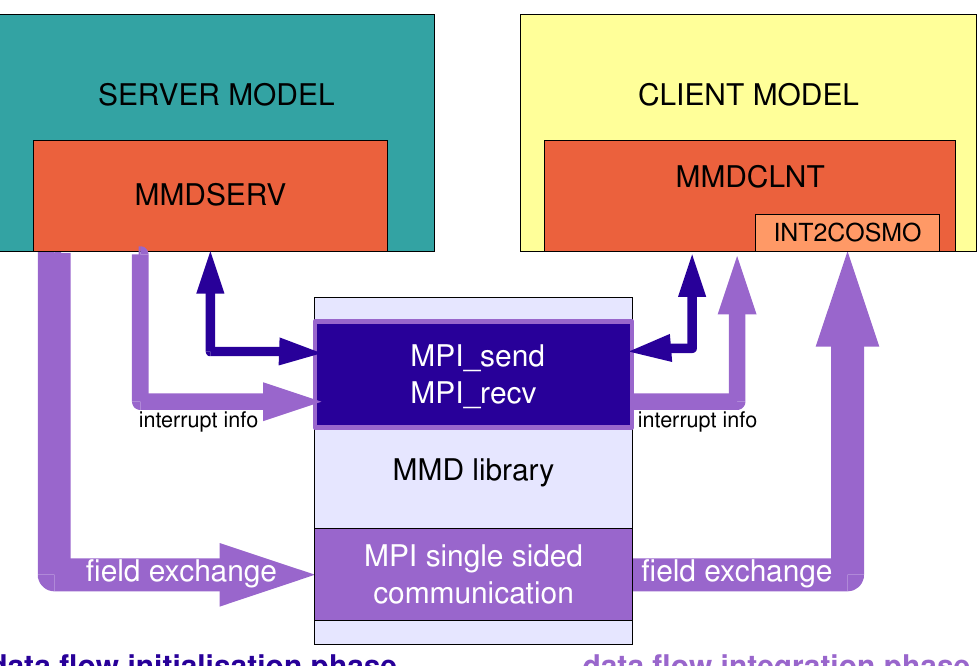
Fig. 3. Data exchange between the different model components: during the initialisation phase information is exchanged via MPI direct communication between the server and the client model (dark blue arrows). During the integration phase the server provides the in-fields to the client via MPI point-to-point single sided non-blocking communication (violet). The additional information, if the server is interrupted after the current time step (e.g. for restarts), is exchanged each server time step using MPI direct